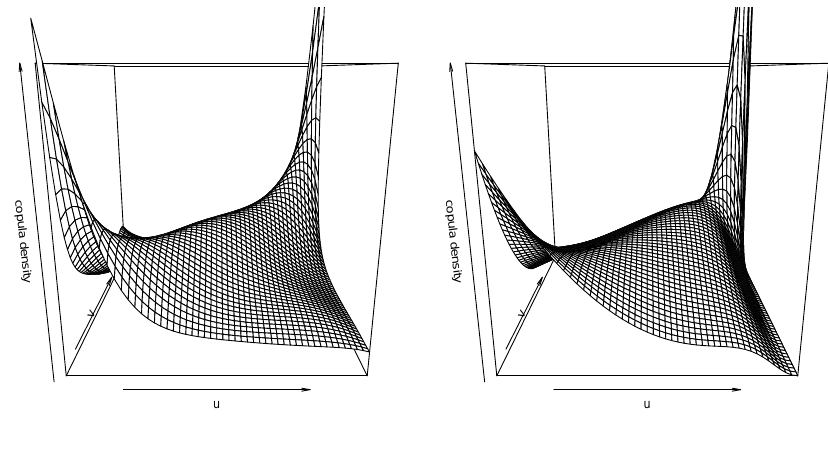
Figure 5: Estimated copula densities of daily Bitcoin and Ethereum returns for binomial (left) and negative binomial (right) gen- erators, the scales are the same in both